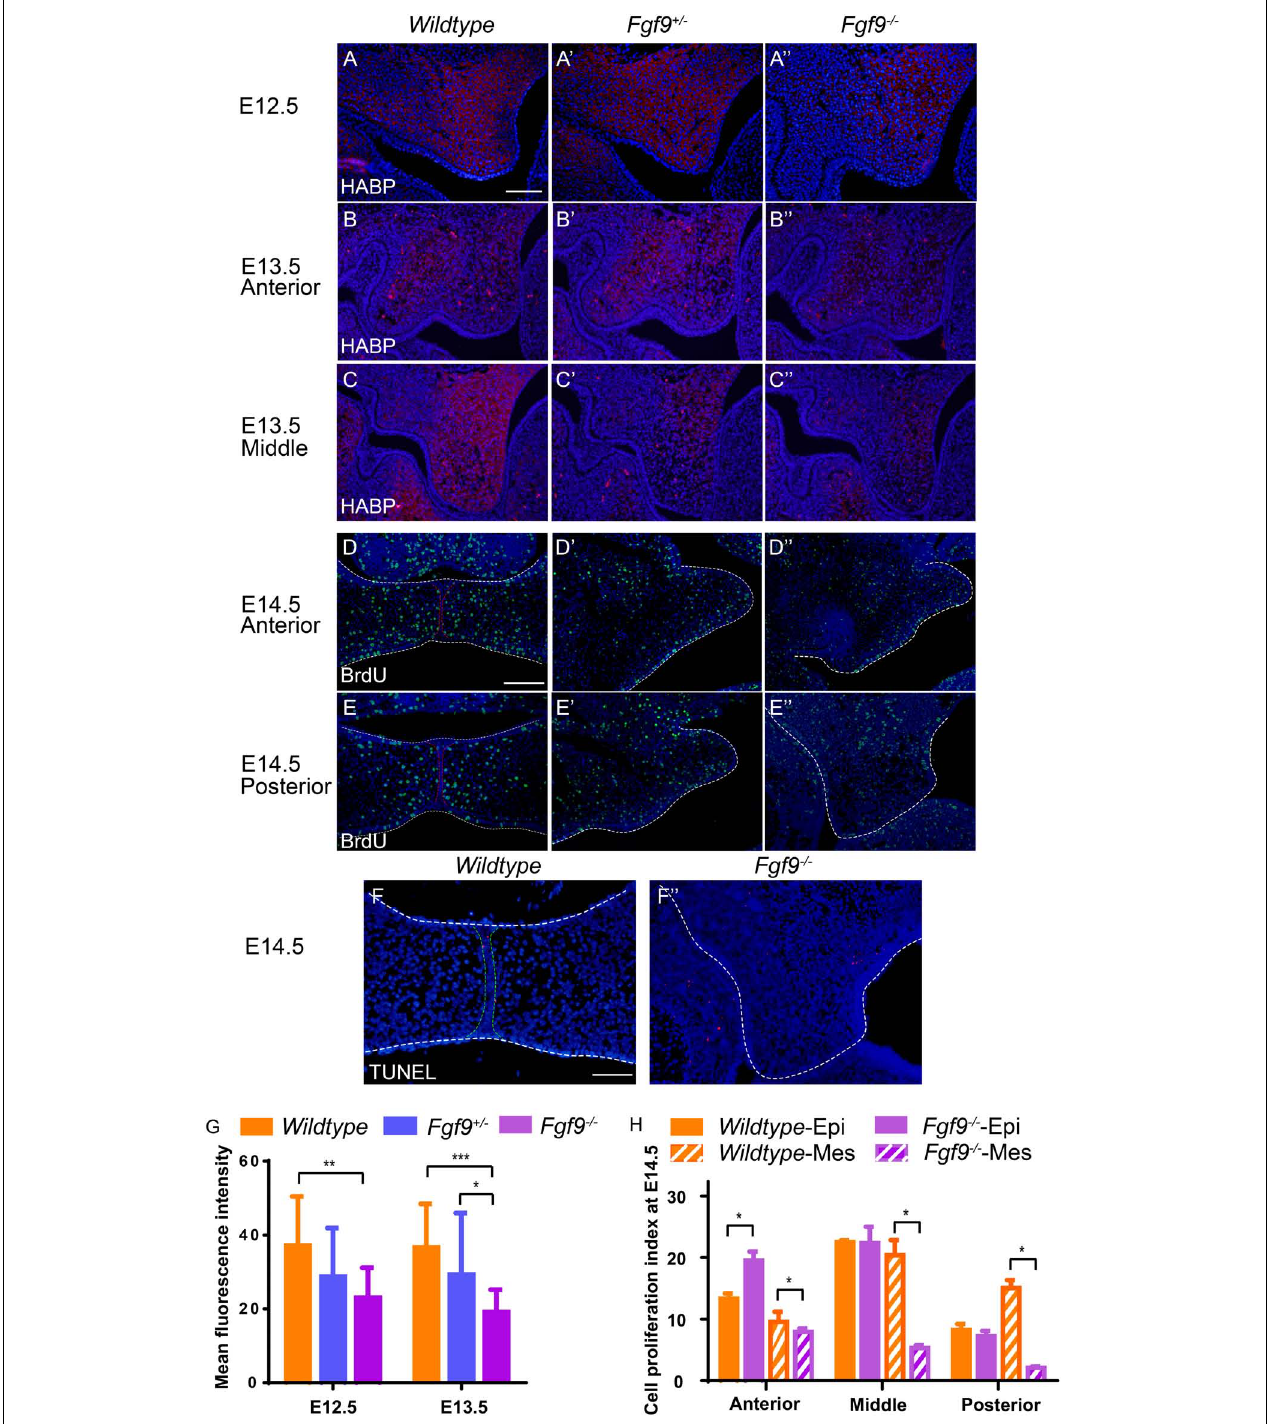
FIGURE 7 | Fgf9 − / − embryos have reduced HA accumulation and cell proliferation. Coronal sections with HABP staining of (A) Wildtype , (A’) Fgf9 + / − , and (A”) Fgf9 − / − embryos at E12.5. Coronal sections with HABP staining through (B–B”) anterior and (C–C”) middle regions of Wildtype , Fgf9 + / − , and Fgf9 − / − embryos at E13.5. Coronal sections with BrdU immunofluorescence through (D–D”) anterior and (E–E”) posterior regions of Wildtype , Fgf9 + / − , and Fgf9 − / − embryos at E14.5. Coronal sections with TUNEL assays of (F) Wildtype and (F”) Fgf9 − / − embryos at E14.5. (G) Quantification of mean fluorescence intensity in Wildtype , Fgf9 + / − , and Fgf9 − / − embryos at E12.5 and E13.5. (H) Quantification of cell proliferation index through anterior, middle, and posterior regions in the epithelium and mesenchyme of the Wildtype and Fgf9 − / − embryos at E14.5. HABP, hyaluronic acid binding protein. Epi, epithelium. Mes, mesenchyme. * P < 0.1, ** P < 0.05, *** P < 0.001. Scale bars = 100 µ m.